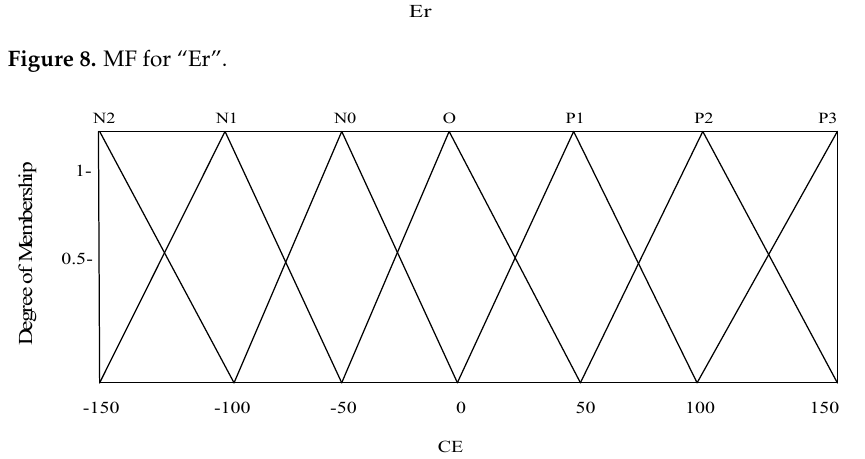
Figure 8. MF for “Er”.